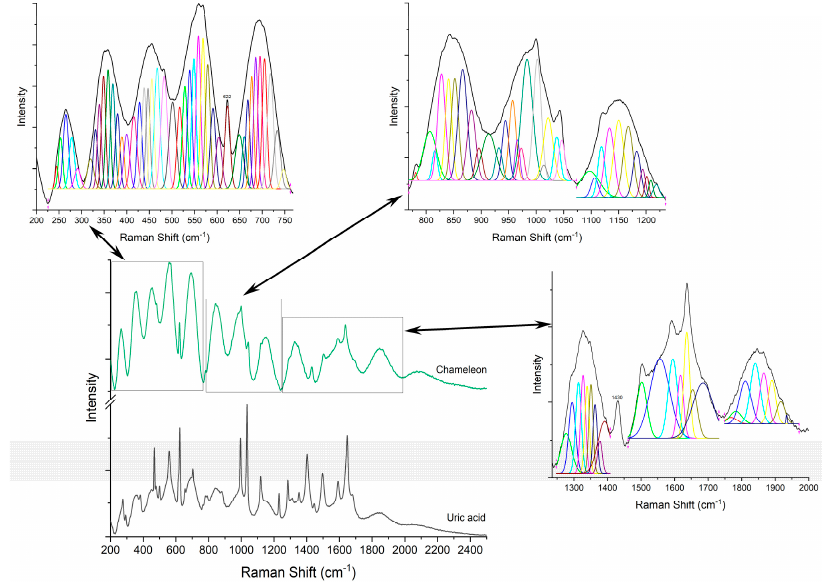
Figure 4. Raman spectra of pure uric acid and, respectively, chameleon sample.